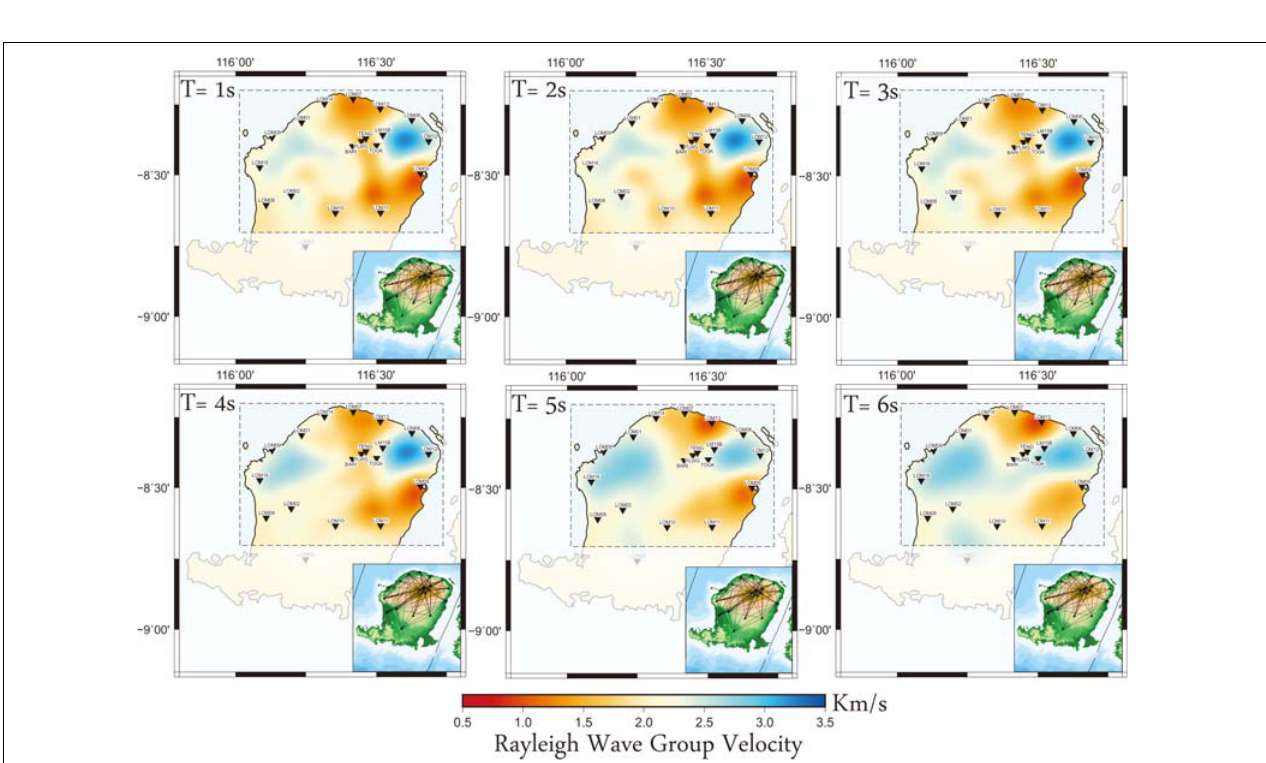
FIGURE 7 | Result of Rayleigh wave velocity group tomograms for periods 1 and 6 s in Lombok. Insets show the ray path distribution in each period. Blue and red colors indicate high and low Rayleigh wave group velocity values, respectively.